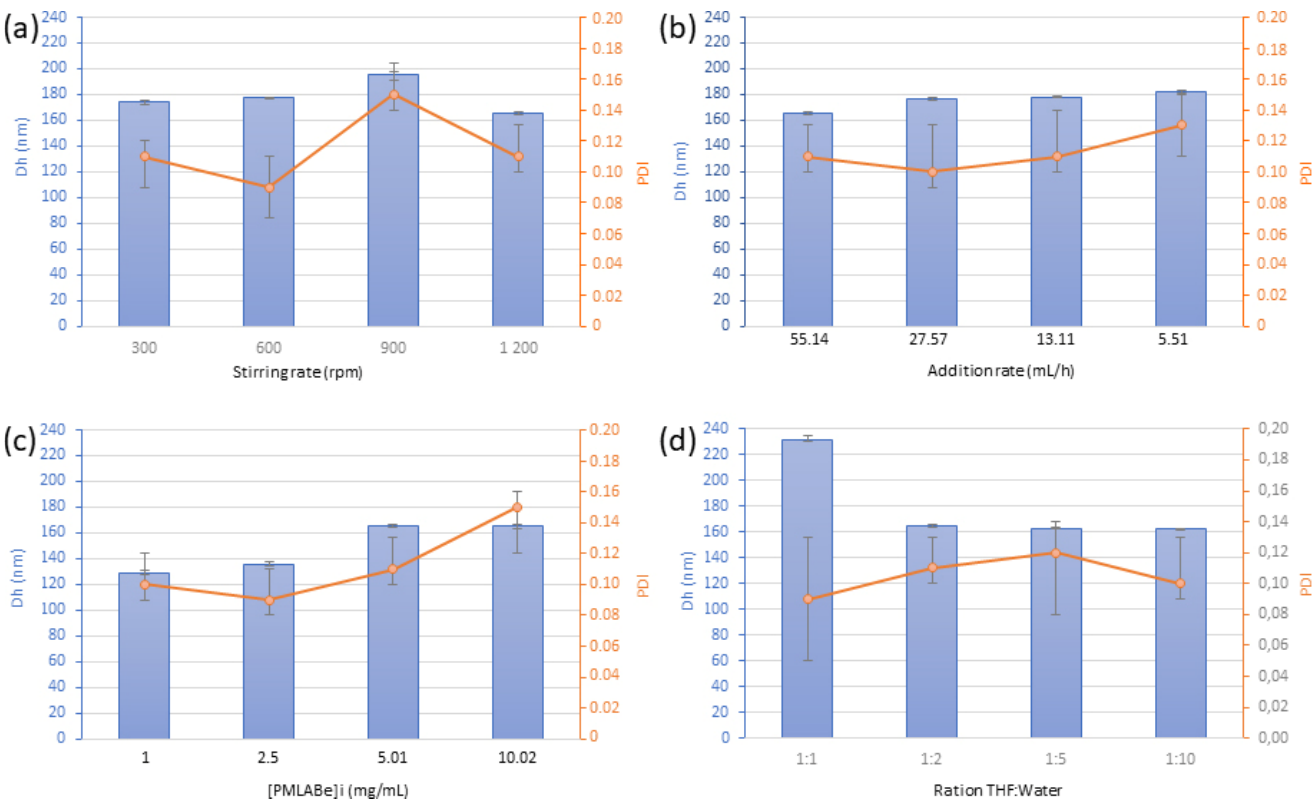
Figure 2. Evolution of NP hydrodynamic diameter (Dh) and dispersity (PDI), measured by DLS, as a function of: ( a ) the stirring rate during nanoprecipitation, using a concentration of polymer of 5 mg/mL, an addition rate of 55.14 mL/h and a THF:water ratio of 1:2; ( b ) the organic phase addition rate, using a concentration of polymer of 5 mg/mL, a stirring speed of 1200 rpm and a THF:water ratio of 1:2; ( c ) the PMLABe 73 initial concentration, using a stirring speed of 1200 rpm, an addition rate of 55.14 mL/h and a THF:water ratio of 1:2 and ( d ) the THF:water ratio, using a concentration of polymer of 5 mg/mL, a stirring speed of 1200 rpm and an addition rate of 55.14 mL/h.